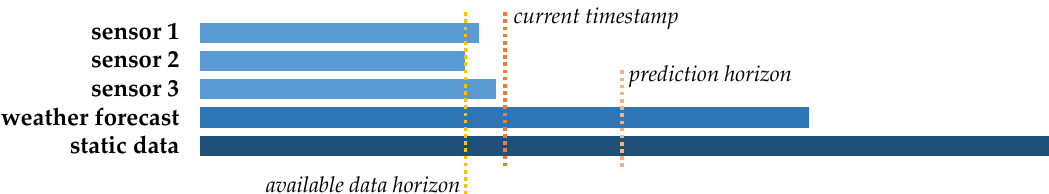
Figure 1. Data availability of different types of data sources. Sensor data is delivered in (almost) real-time. However, some legacy systems might introduce longer lags. Weather forecasts are available for a particular time in the future, while static data (i.e., date/time features and human behaviour data) are usually always